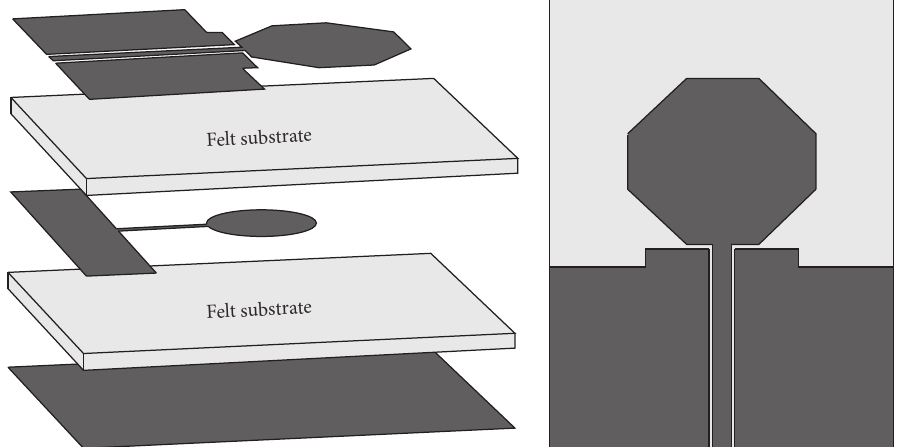
Figure 43: Geometry of an all-textile UWB antenna with low back radiation for WBAN applications [145]. Dark gray conductive textile and light gray dielectric textile